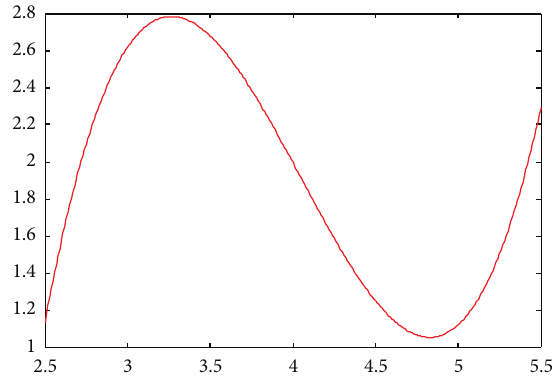
Figure 9: The diagram of Malmquist product index DMU 9